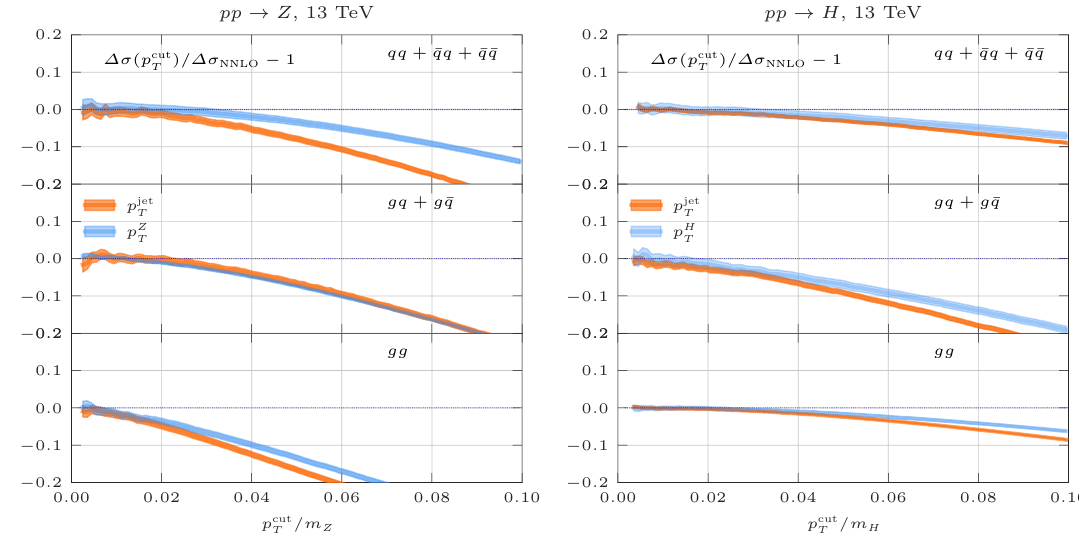
Figure 3 . NNLO correction for Z (left panel) and H (right panel) production: leading-jet p T subtraction (blue) against q T subtraction (blue) and analytic